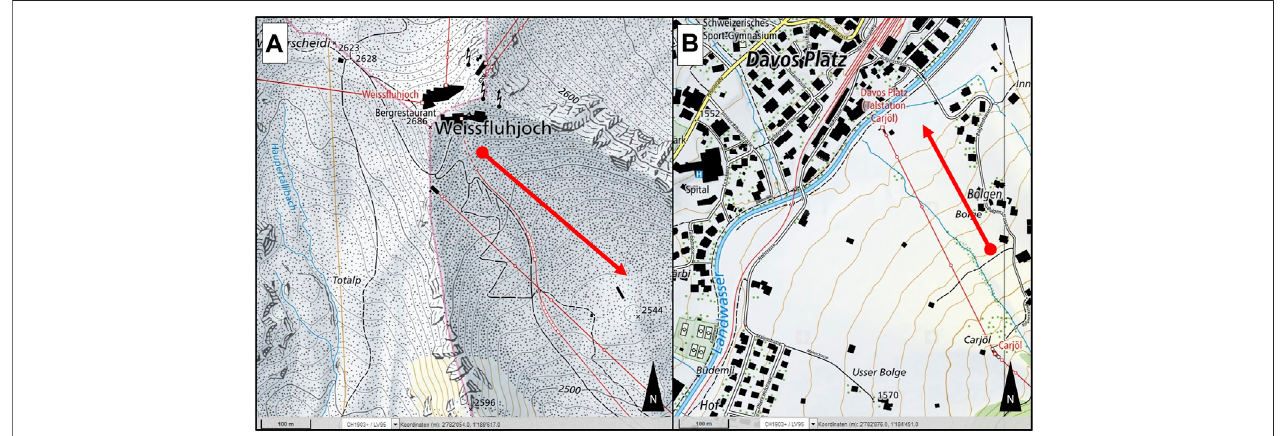
FIGURE 1 | Location of the gliding tracks (red arrows) at Weiss fl uhjoch (A) and Bolgen (B) ( © swisstopo, 2021).